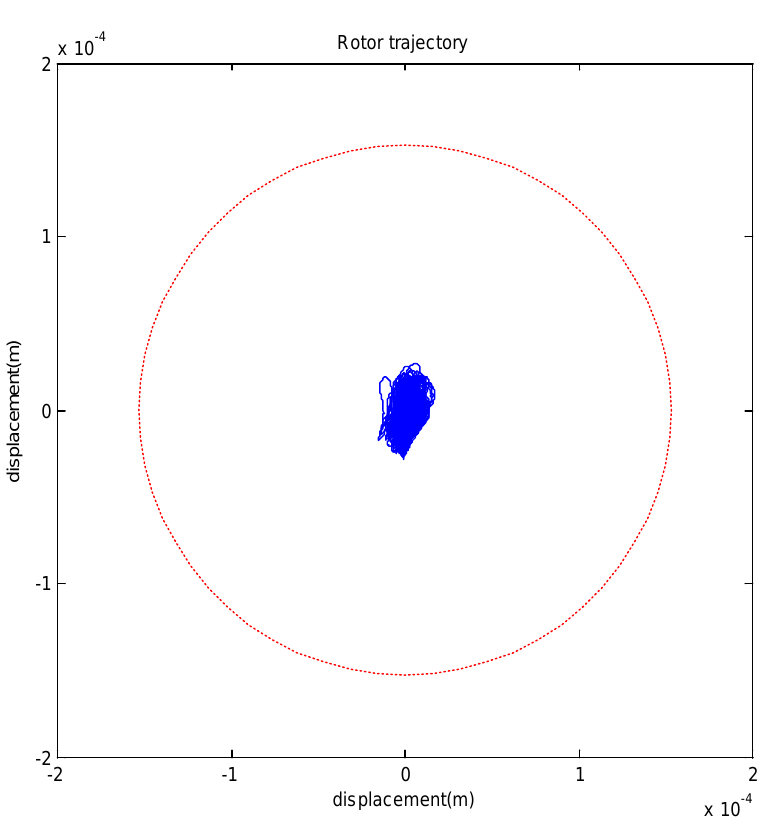
Figure 6. Experimental result: rotor trajectory.